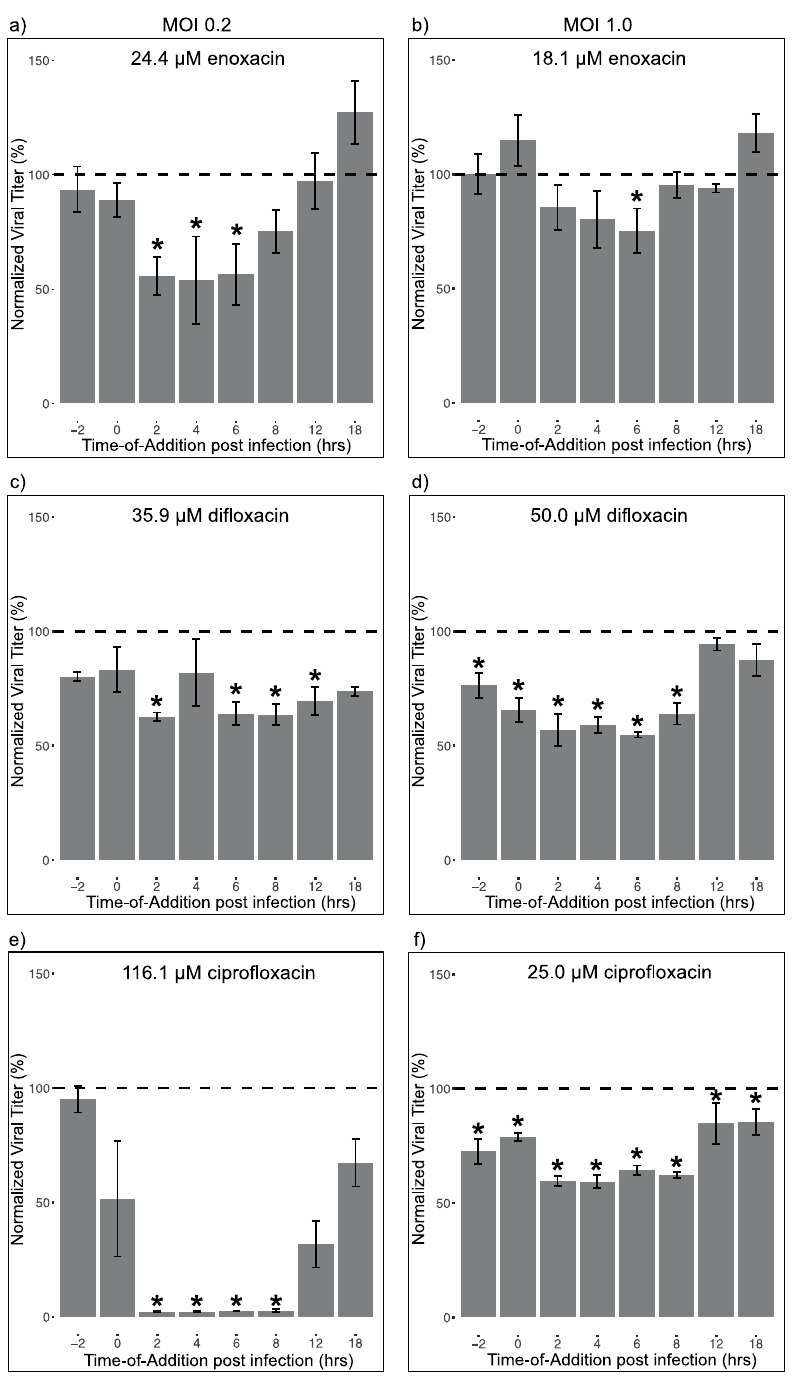
Figure 2. Enoxacin suppresses intermediate life cycle stages of ZIKV while difloxacin and ciprofloxacin suppress early and intermediate life cycle stages of ZIKV. Results of time-of-addition assays of each of three fluoroquinolones against ZIKV at designated drug concentrations and virus multiplicities of infection (MOIs) (see text for justification of drug concentration and MOI pairings): for enoxacin ( a , b ), difloxacin ( c , d ), and ciprofloxacin ( e , f ). Viral titers ( n = 3 replicates per drug per time point) for each time point were normalized to the average viral titer with media treatment and reported as average percent (titer at time point/average media titer*100). Differences in mean viral titers (log 10 pfu/mL) were detected with ANOVA and pairwise t -tests; full pairwise statistics in Table S1. * p < 0.05 compared to media control.